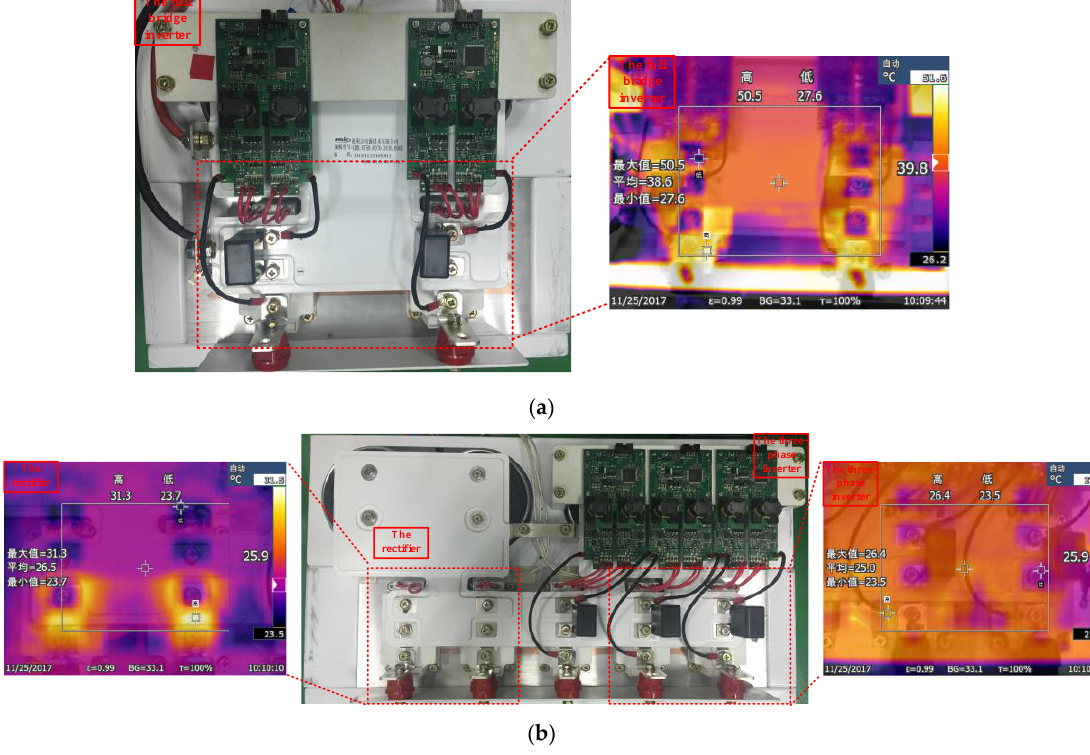
Figure 20. The thermal images of three modules ( a ) the full bridge inverter; ( b ) the rectifier and the three-phase inverter